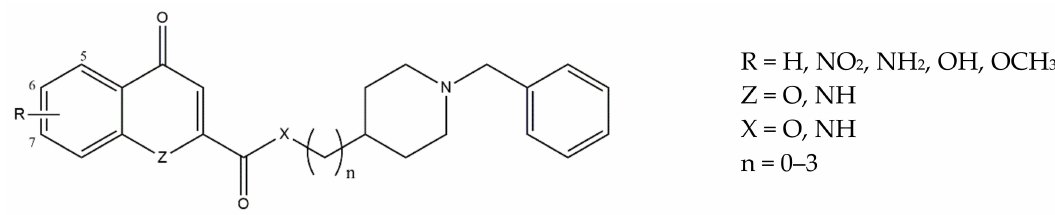
Figure 6. General structures of 4-chromenone and 4-quinolone classes of ligands. The best compromise among all studied compounds is represented by compound 8 (R = 6,7-diOMe; Z = O; X = NH and n = 2, Figure 6), which showed good neuroprotective prop- erties: h AChE IC 50 = 46 nM; h BuChE IC 50 >10000 nM; PAMPA-BBB = 5.9 × 10 − 6 cm s − 1 ; 5-LOX IC 50 = 74.3 µ M; MAO-A IC 50 = 15.3 µ M; MAO-B IC 50 = 5.2 µ M; ORAC = n.a.; σ 1 R K i = 37.4 nM; σ 2 R K i = 239